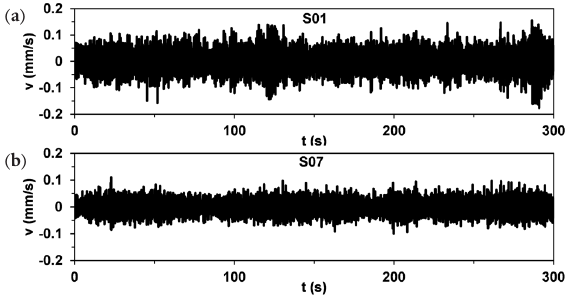
Figure 6. Time histories recorded at locations at the top of the wall in configuration C1 at (a) S01 and (b)